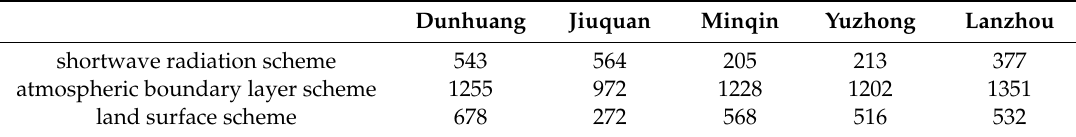
Table 5. The average value of the bias of the simulation results for each parametric scheme from 4:00 to 10:00 on 3 June (Unit: